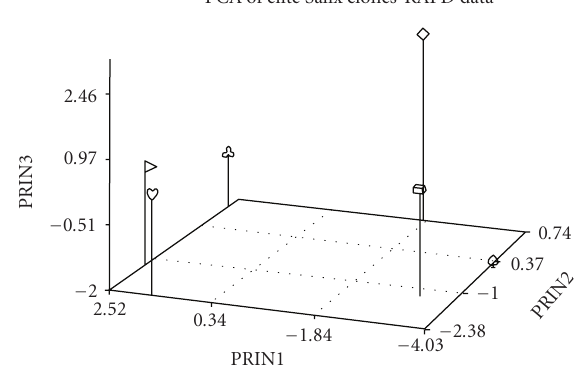
Figure 3: Ordination of Salix clones on three-dimensional prin- cipal space based on the analysis of dominant (RAPD) genetic markers. Designations: heart: S267, club: S259, S289 (coinciding multilocus genotypes), diamond: S301, spade: S353, cube: S354, flag: